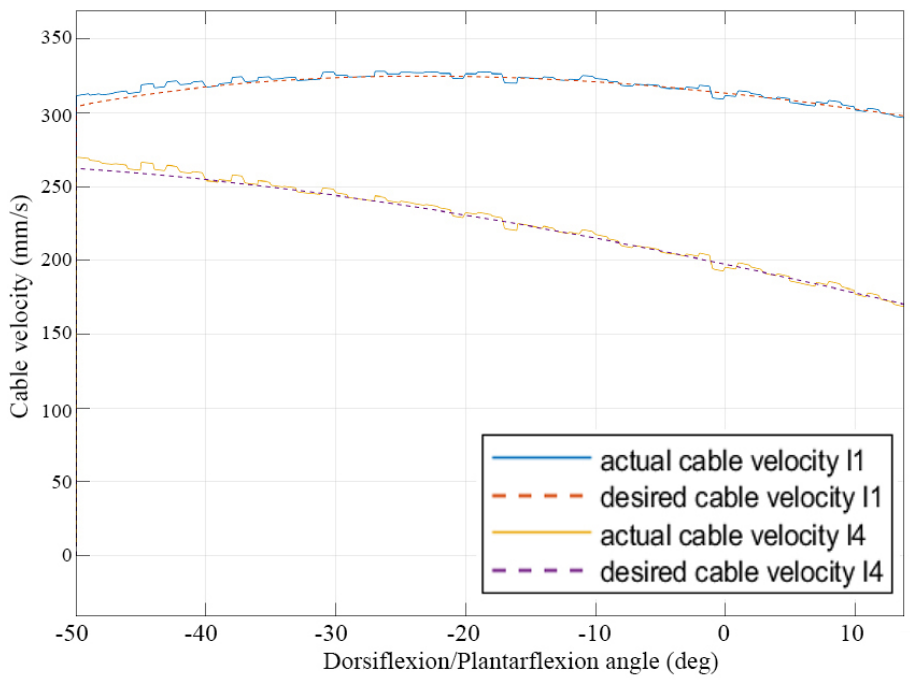
Figure 10. Desired and computed cable velocity values for a simulated operation of a controlled ankle assisted motion exercise. ankle assisted motion